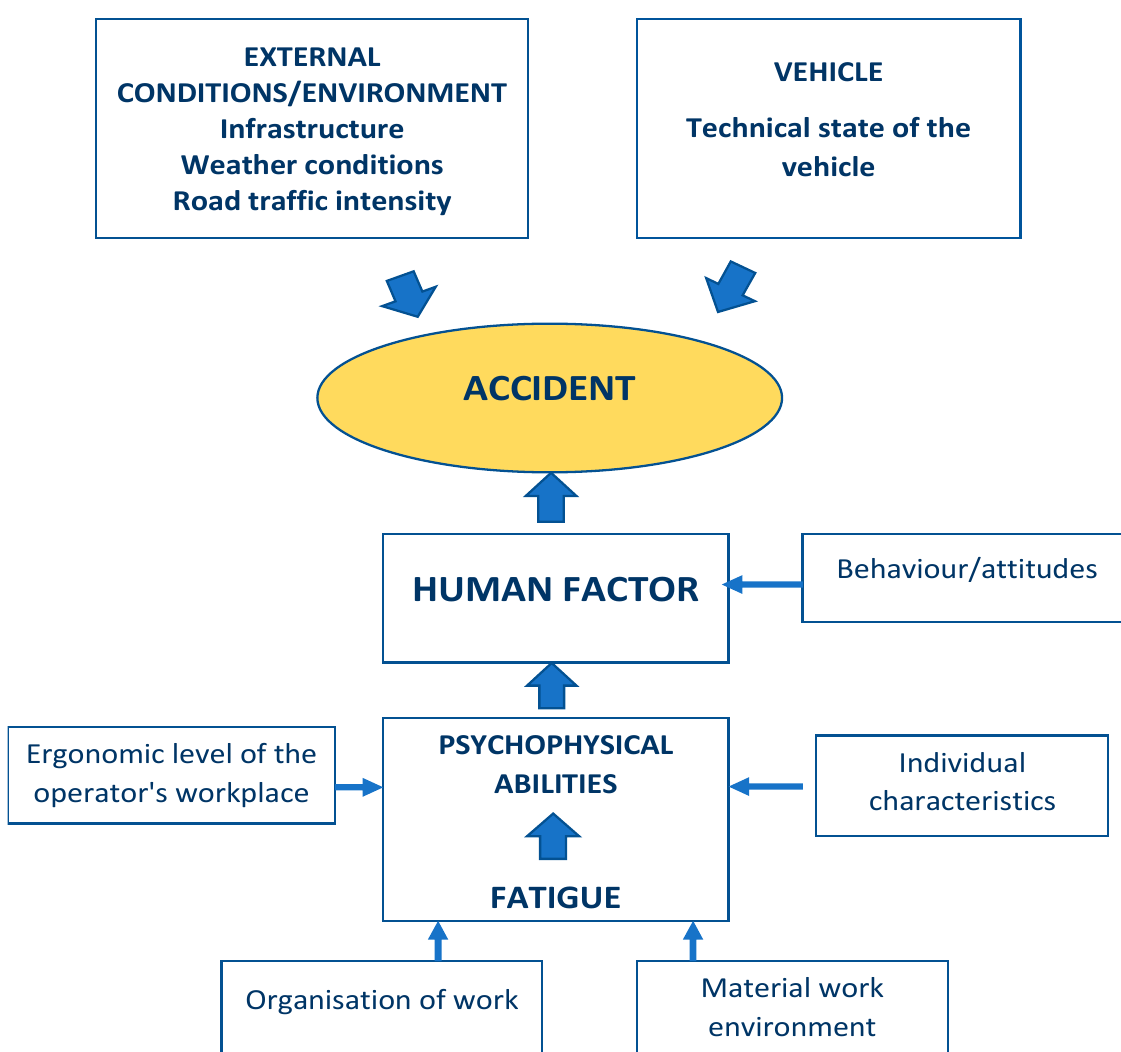
Figure 1. Factors potentially influencing probability of an accident.